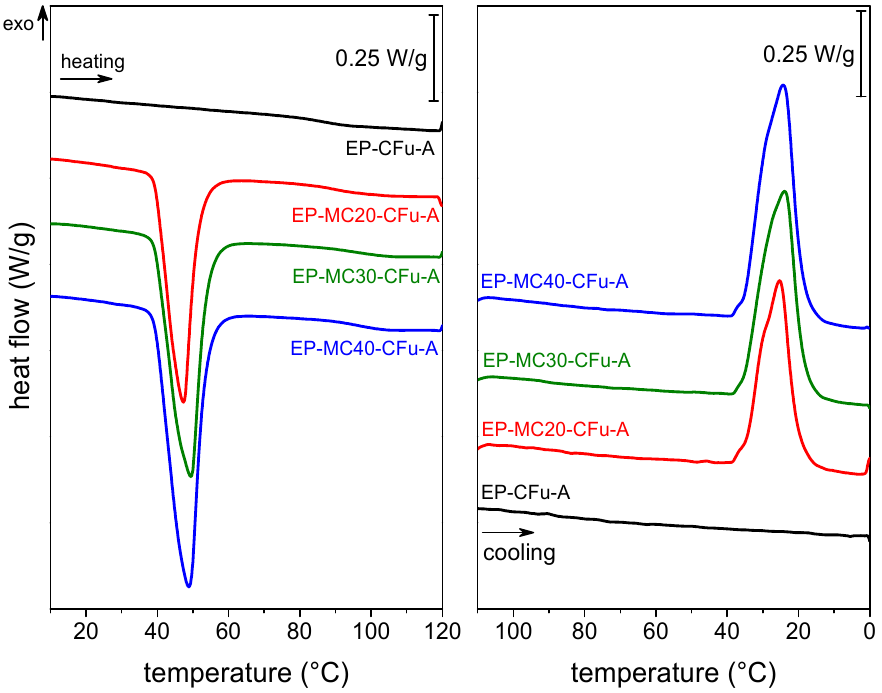
Figure 2. Representative DSC thermograms of laminates EP-MCx-CFu-A. First heating scan and cooling scan. Reprinted with permission from [41]. Table 1. Main results of DSC tests and volumetric composition of the prepared laminates. Data from [41].